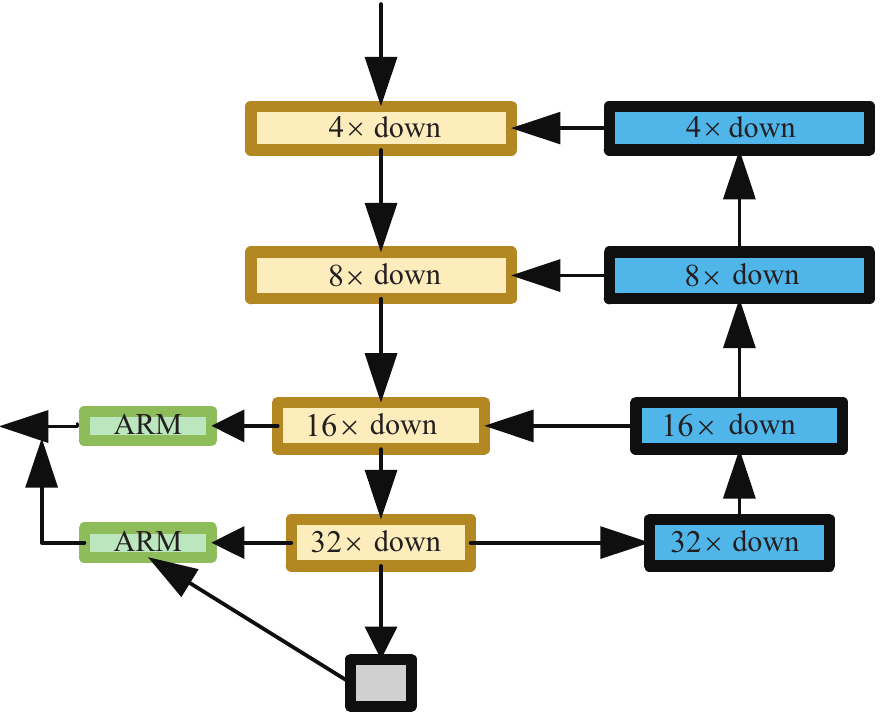
Figure 8. Improved contextual path. Expand the receptive field by using residual networks and global average